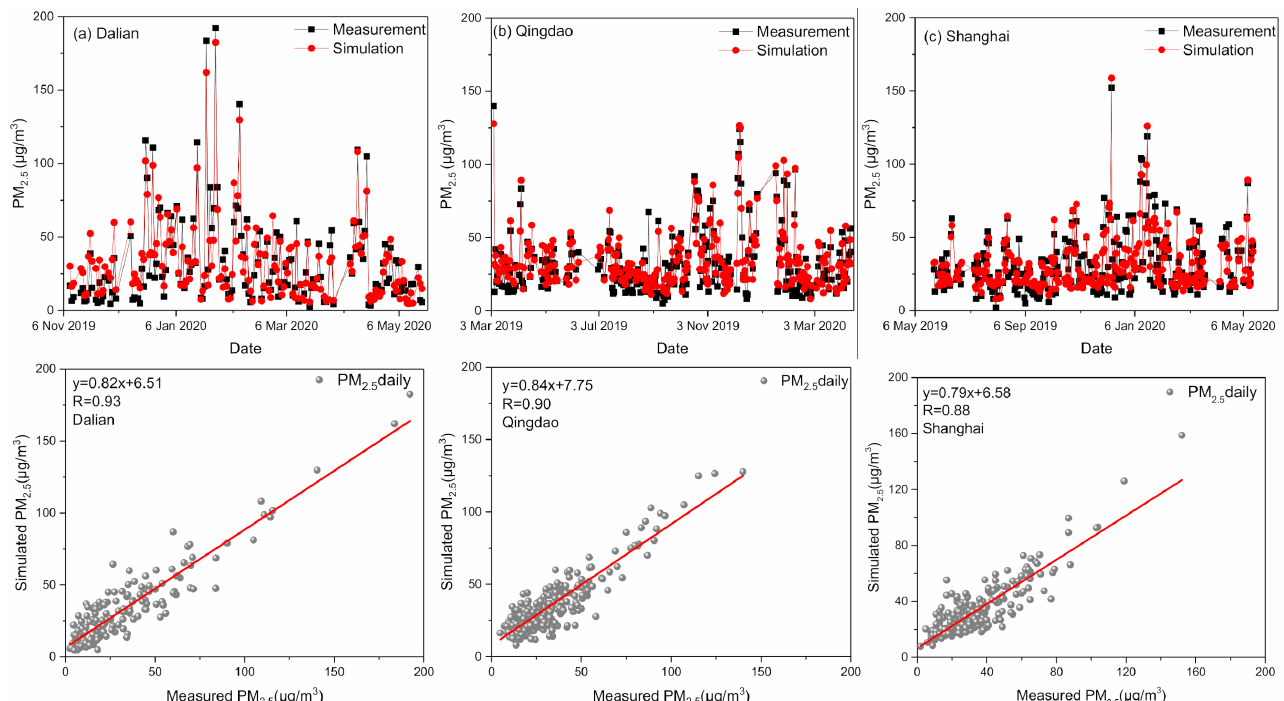
Figure 4. The correlation of the PM 2.5 measured by the in situ instrument and the PM 2.5 simulated by conversion formulas in Dalian ( a ), Qingdao ( b ), and Shanghai ( c